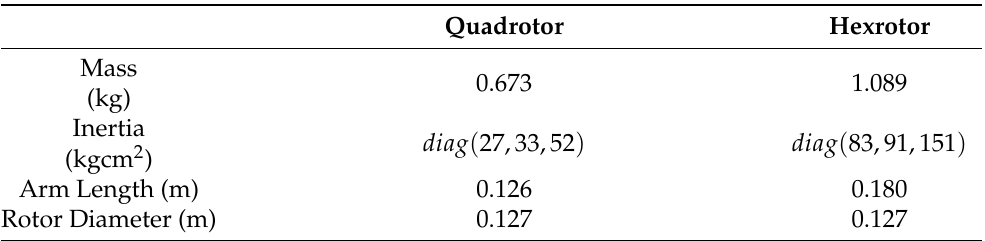
Figure 4. Closed-loop control system for a multirotor UAV, where α is the mean output, M is the total moment, T is the total thrust, and s is the vehicle’s state. Table 1. Physical properties of vehicles. Diag ( a ) is the 3 × 3 diagonal matrix with entries that are the three elements of vector a